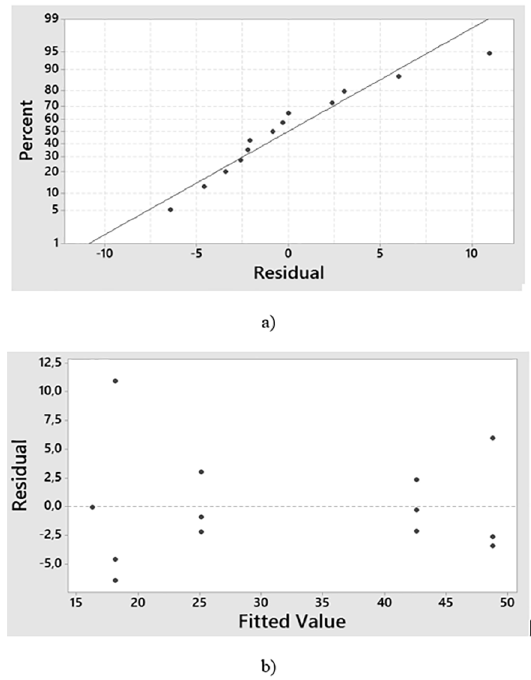
O . a) normal probability plot, 2 3